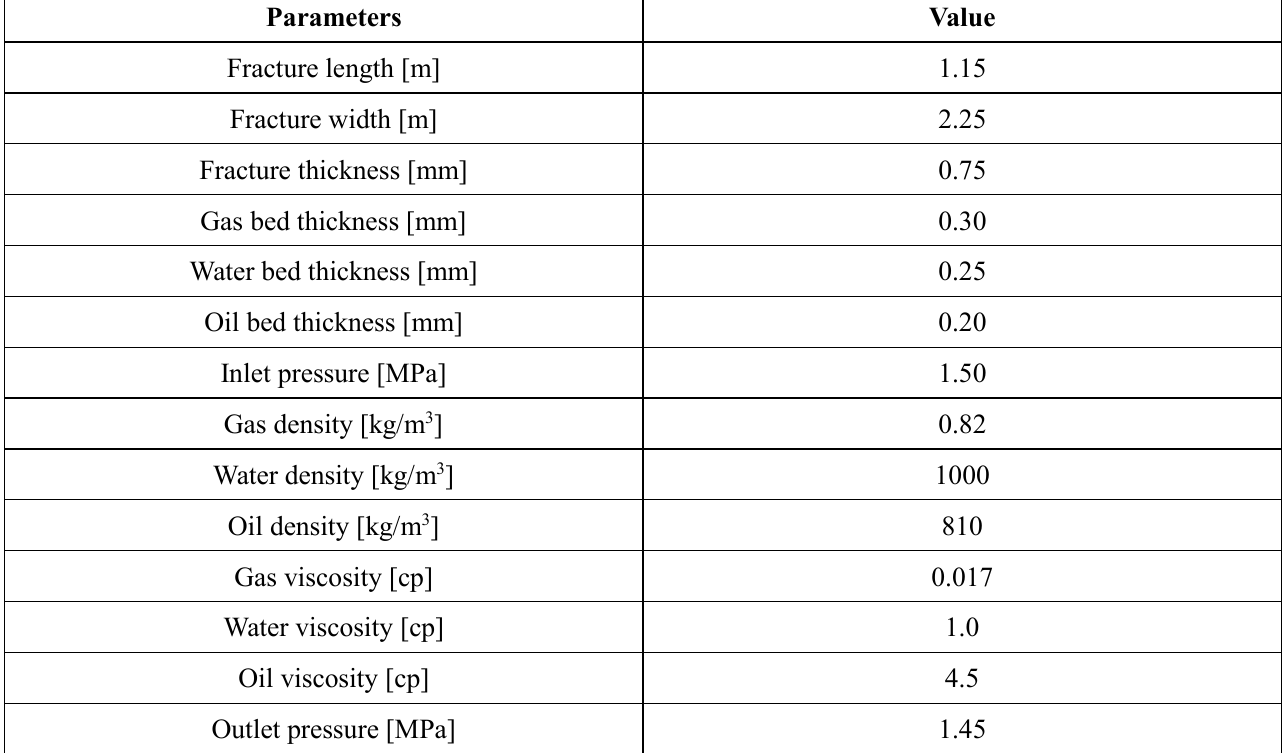
Table 1-Basic parameters applied in the